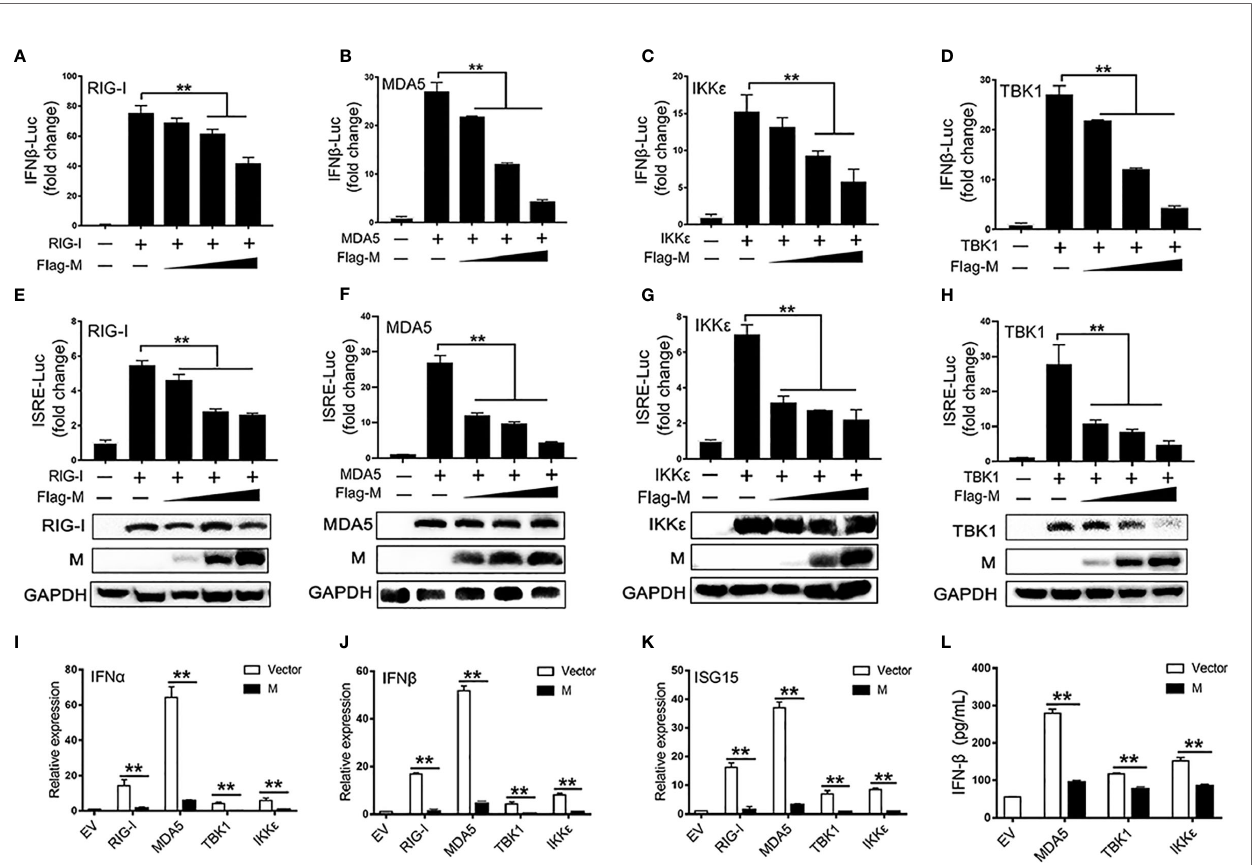
FIGURE 1 | The SARS-CoV-2 M inhibits IFN-I signaling. (A – H) HEK293T cells in 24-well plate were transfected with an IFN b or ISRE reporter plasmid, along with a control plasmid or with increasing amount of Flag-M (0.2, 0.4, and 0.8 m g), together with plasmids expressing RIG-I (A, E) , MDA5 (B, F) , IKK ϵ (C, G) , or TBK1 (D, H) . At 24 h post-transfection, luciferase activity was measured. The expression levels of indicated proteins were analyzed by immunoblot. (I – K) . Flag tagged empty vector or Flag-M and RIG-I, MDA5, TBK1 or IKK ϵ expression plasmids were co-transfected into HEK293T cells. After 20 h, cells were harvested and relative mRNA levels of type I IFN and ISGs genes expression were analyzed by qPCR. GAPDH was used as a normalizer. (L) . Flag tagged empty vector or Flag-M and MDA5, TBK1 or IKK ϵ expression plasmids were co-transfected into HEK293T cells. After 24 h, culture supernatant was harvested and secreted IFN b was detected by ELISA. Bars represent the mean of three biological replicates (n = 3) and all data are expressed as mean ± SE. **p <